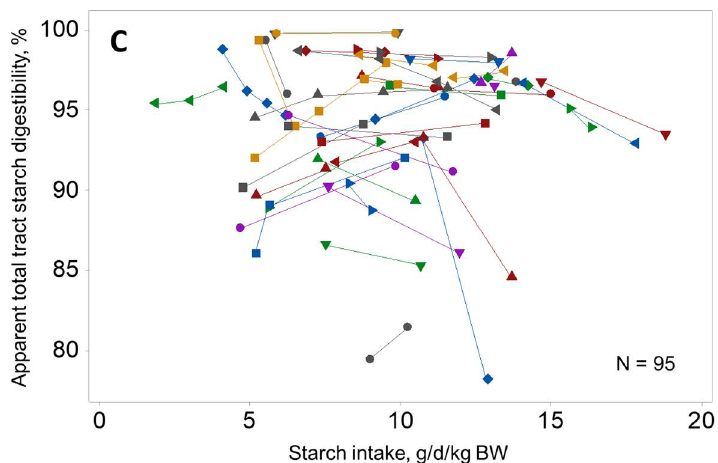
Figure 1. Literature summary showing the relationship between ( A ) starch flow at the duodenum and starch intake, ( B ) fecal starch content and starch flow at the duodenum, and ( C ) apparent total tract starch digestibility and starch intake. Each line represents one experiment group and the total number of means included (N) is specified in each graph. BW = body weight.